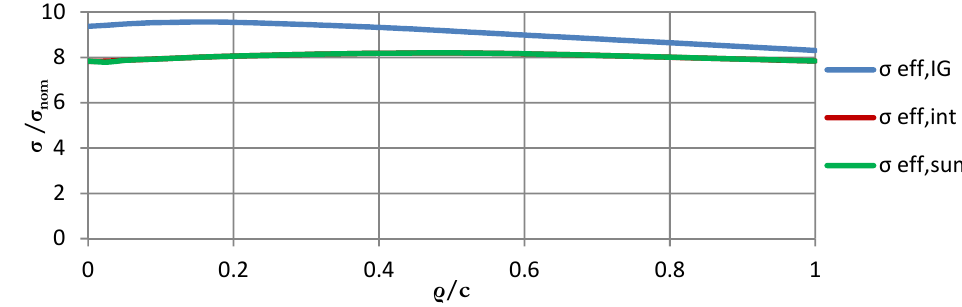
Figure 6: Trend of σ eff,IG Vs σ eff,int Vs σ eff,sum on the filled